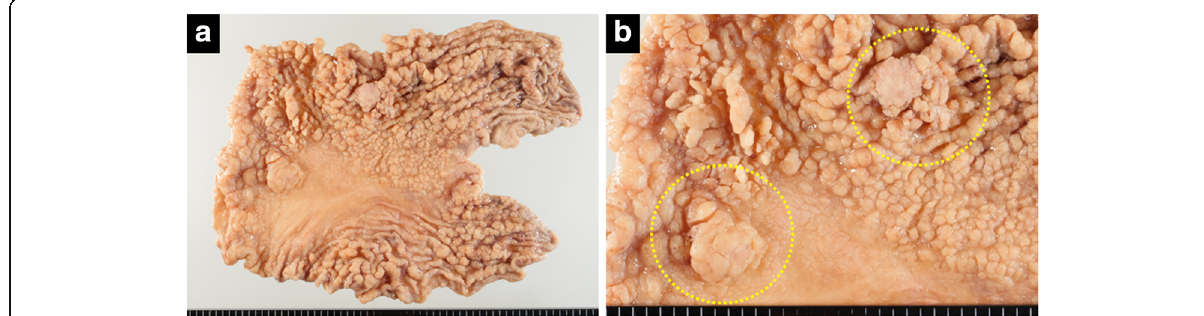
Fig. 2 Resected specimen revealed numerous small and large polyps throughout the stomach ( a ) and two elevated lesions in the corpus and angular region (circle), respectively ( b